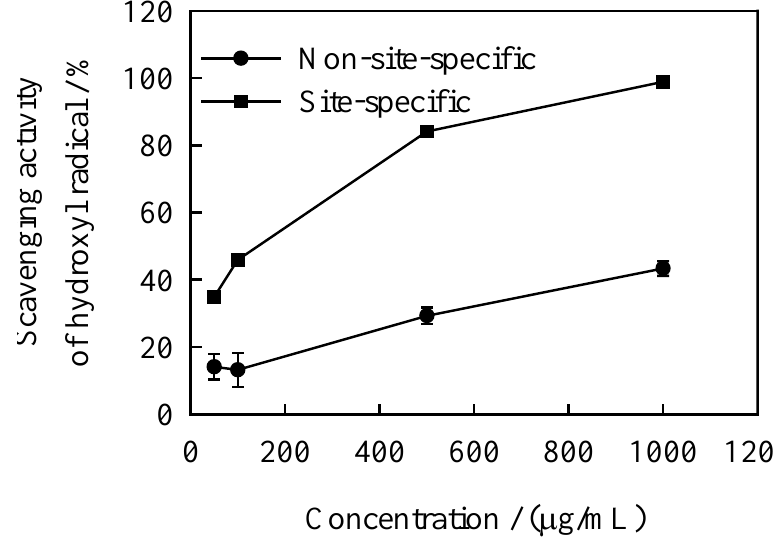
Figure 6 . Inhibitory effect of phenolics from litchi pericarp tissues on deoxyribose degradation in non-site-specific and site-specific